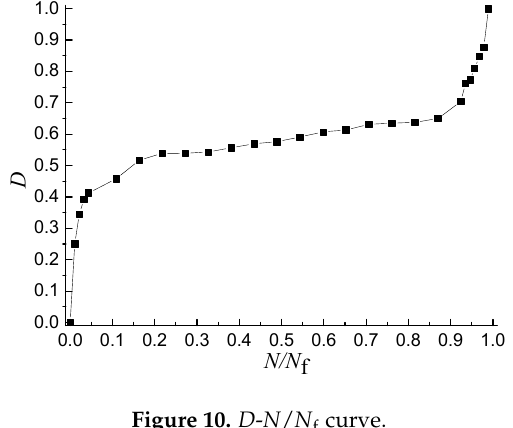
Figure 10. D - N / N f curve.